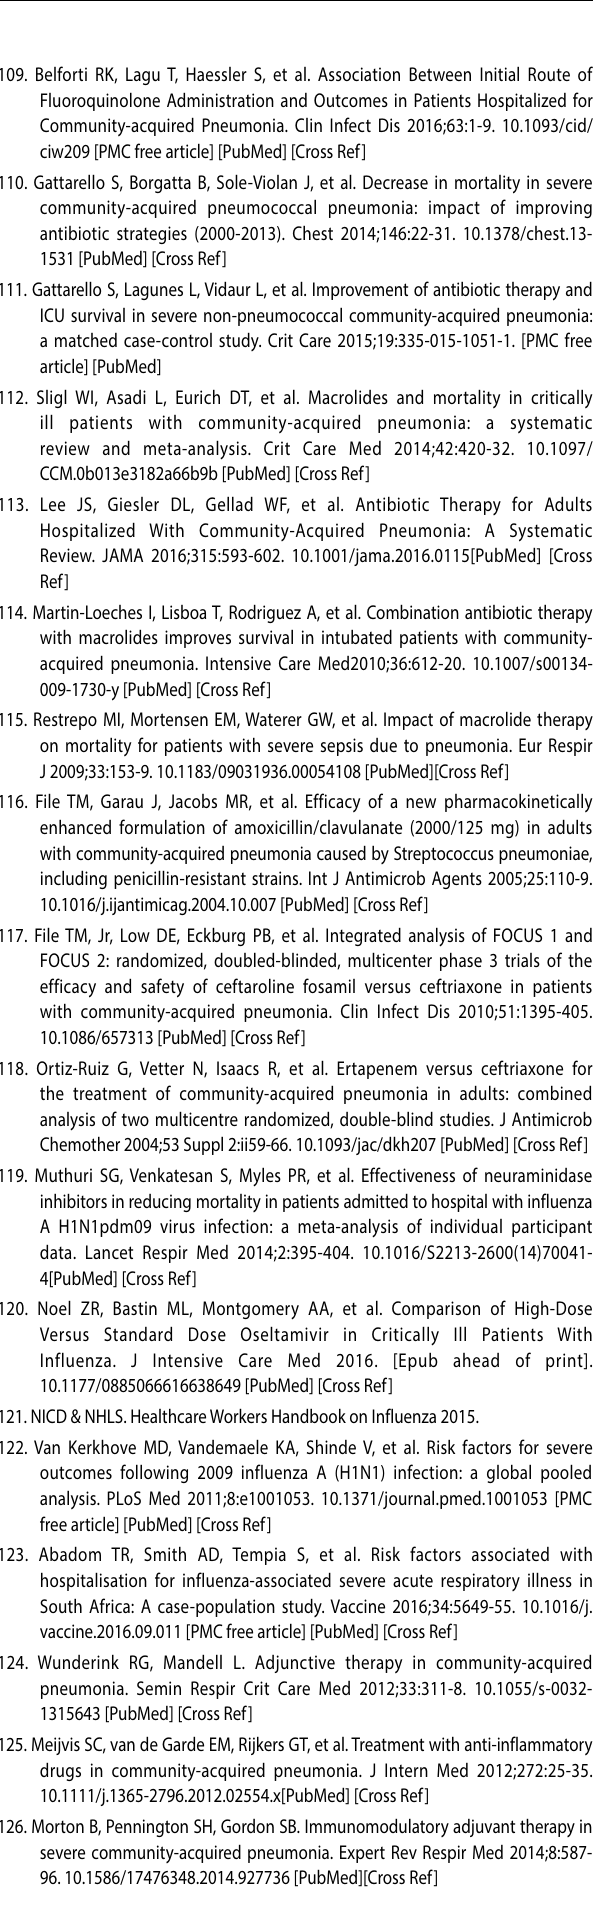
The page number in the footer is not for bibliographic